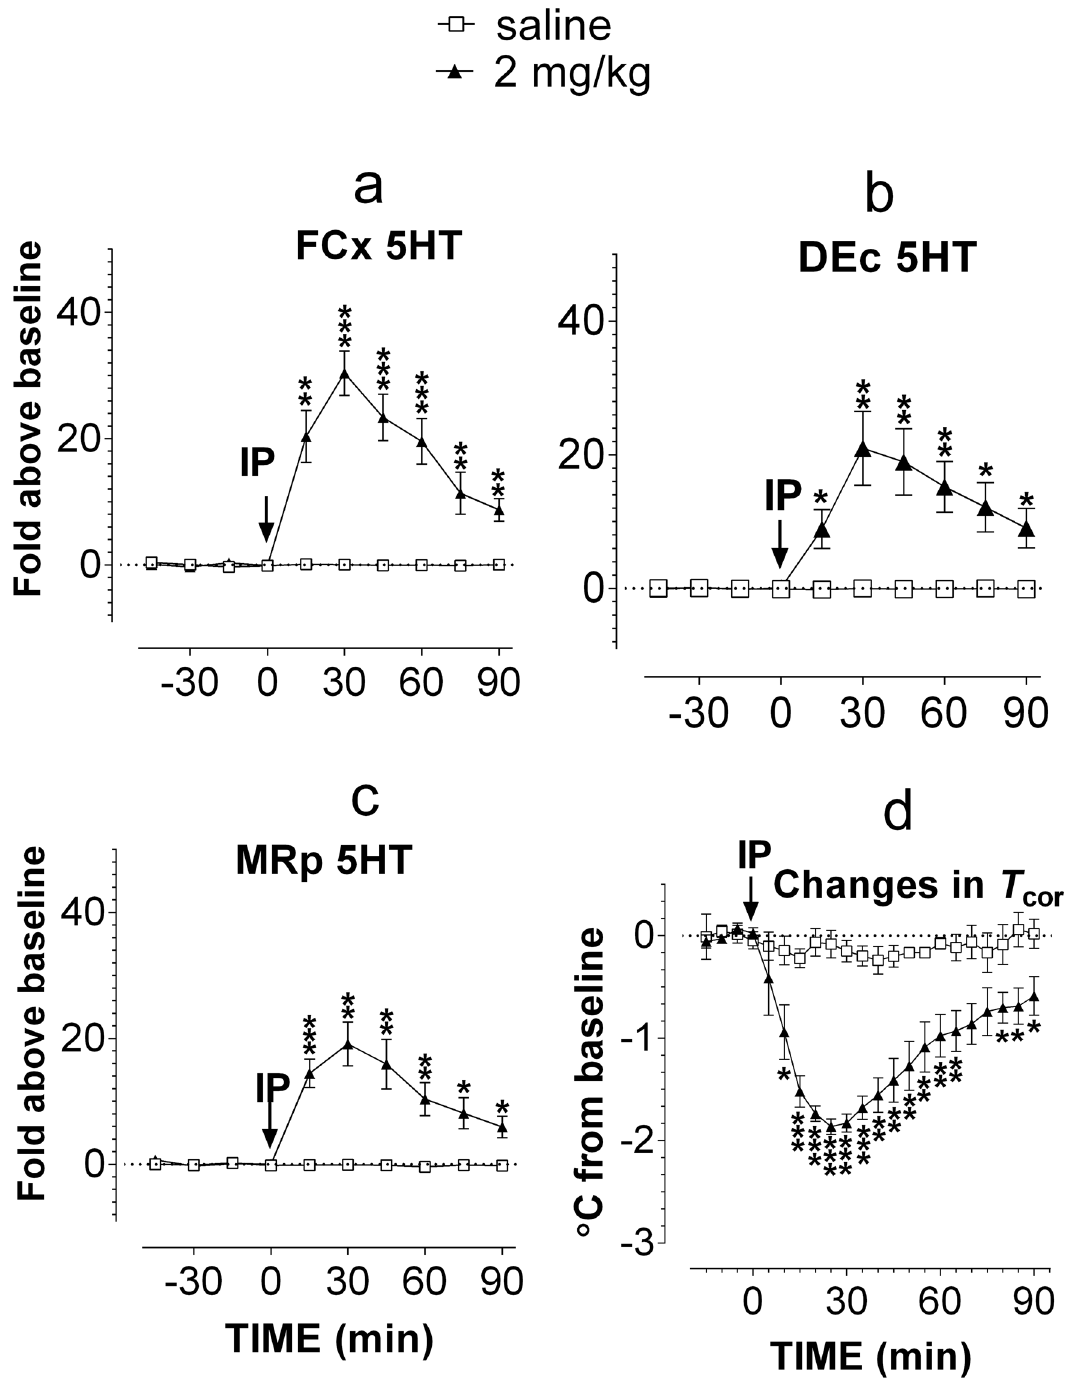
Fig 1. Relationship between systemic injection of MDMA and occurrence of serotonin syndrome in male Sprague- Dawley rats. The route of systemic administration was IP. Serotonin syndrome was determined by measuring extracellular 5HT in the FCx, DEc and MRp, and further verified by measuring changes in body-core temperature ( T cor ). Arrows indicate time of IP injection at a dose of 2 mg/kg MDMA. Data are expressed as mean ± s.e.m. Extracellular 5HT is excessively elevated ( > 10-fold) in a, the FCx (n = 5 rats/group); b, the DEc (n = 5 rats/group); c, the MRp (n = 4 – 5 rats/group). d, T cor becomes hypothermia (n = 5 rats/group). * P < 0.05 vs . saline control, determined by Scheffe ’ s test followed by one-way repeat measures